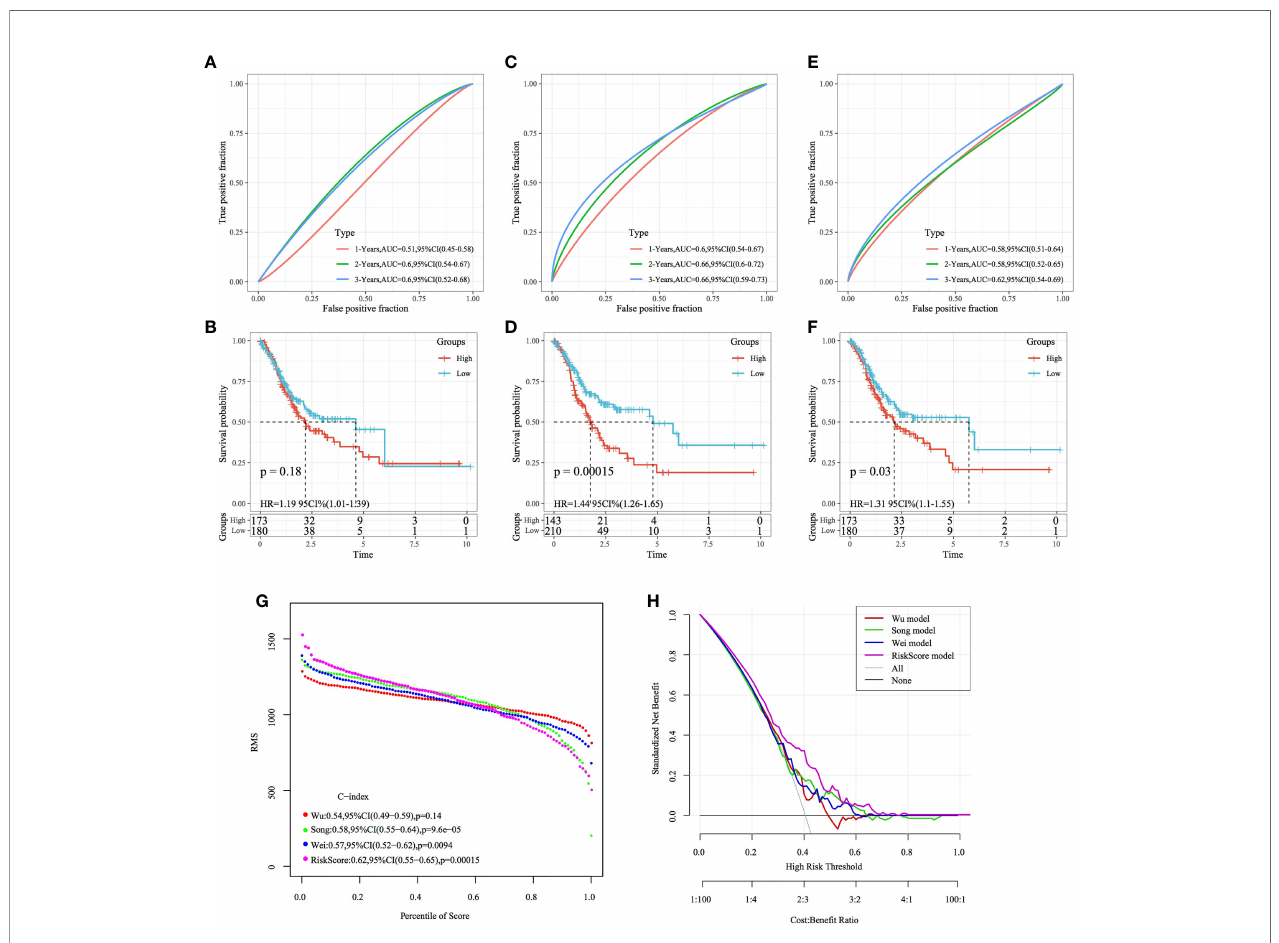
FIGURE 14 | Comparison of the four-gene signature with other signatures. (A, B) ROC curve of a risk model based on a three-gene signature (Wu) and KM curve of the high- and low-risk groups. (C, D) ROC curve of a risk model based on a fi ve-gene signature (Song) risk model and KM curve of the high- and low-risk groups. (E, F) ROC curve of a risk model based on an eight-gene signature (Wei) and KM curve of the high- and low-risk groups. (G) C-index curves of the models. (H) DCA curves of the